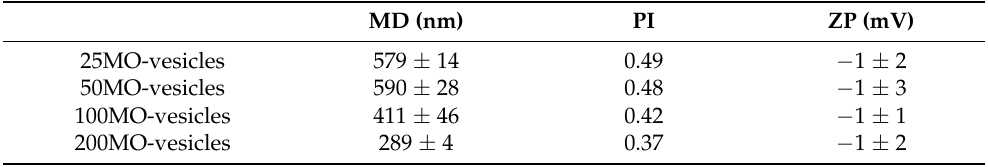
Table 3. Mean diameter (MD), polydispersity index (PI) and zeta potential (ZP) of vesicles diluted with simulated saliva medium at pH 6.75. Diluted samples were stored at 37 ◦ C for 10 min. Mean values ( n = 6) are reported ± standard